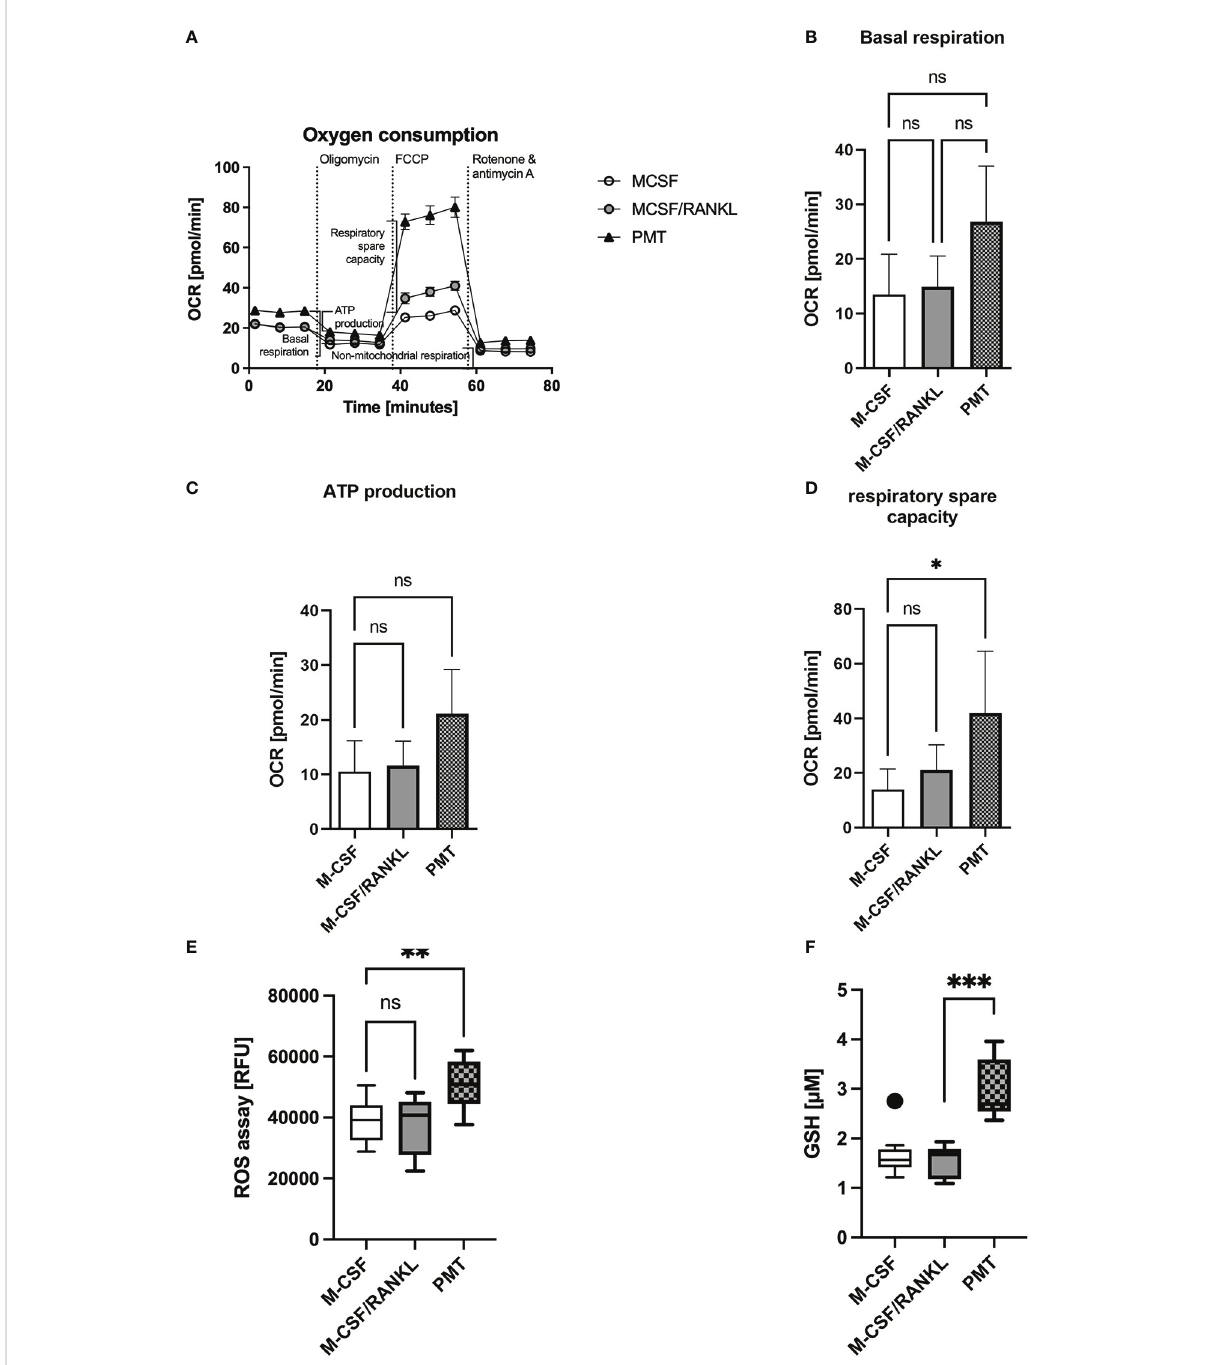
FIGURE 4 PMT treatment increases mitochondrial respiration. (A) Seahorse analysis of mitochondrial activity of BMDM on day 3 of differentiation (Mito Stress Test) (n=3). (B) Quanti fi cation of basal respiration, (C) ATP production and (D) respiratory spare capacity. Statistical analysis was done using a Friedman test for paired samples. (E) Quanti fi cation of ROS production of BMDM on day 3 of osteoclast differentiation (n=5, with triplicates). Statistical analysis was done using a Kruskal-Wallis test on unmatched samples. (F) Glutathione levels of BMDM were quanti fi ed on day 3 of differentiation and luminescence was measured (n=3, in triplicates). Concentration of GSH was calculated using a standard curve with glutathione (16 m M to 0.125 m M). One outlier was removed by Tukey analysis. Statistical analysis was done using a Kruskal-Wallis test on unmatched